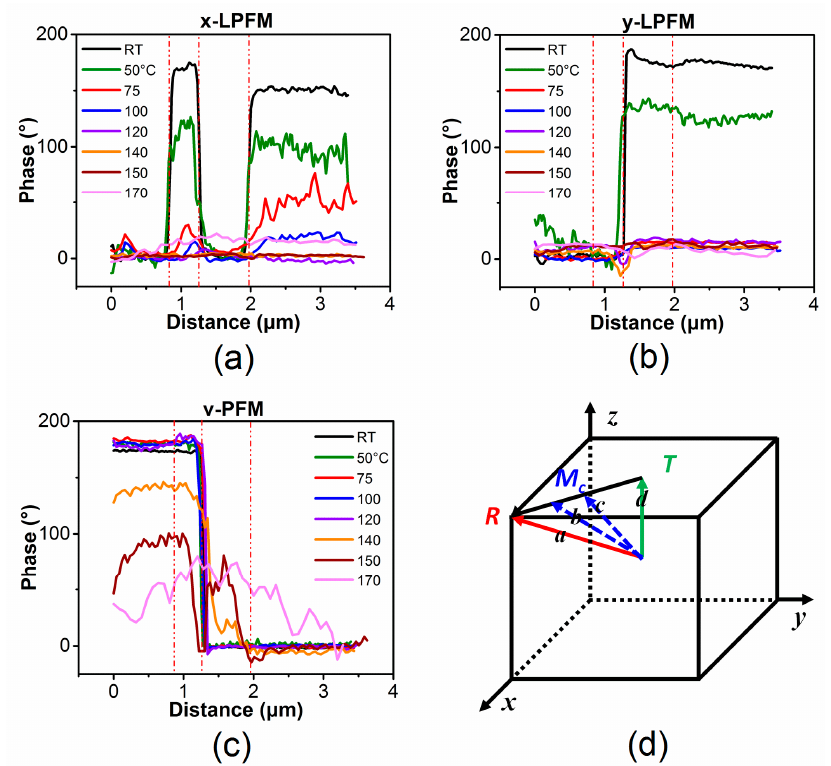
Figure 8. ( a – c ) Extracted profiles of the PFM phase in x-LPFM, y-LPFM, and VPFM along the line indicated in Figure 2a from room temperature to 170 °C; and ( d ) possible polarization rotation path (from R phase to T phase) of the (001)-cut PZN-7%PT single crystal. To summarize, PZN-7%PT undergoes an R → T phase transition at approximately 100 °C, and the T → C phase transition occurs between 140 °C and 170 °C. Based on the revised phase diagram of PZN-x%PT proposed by Chang et al., the de-poling temperature and the Curie temperature ( T C ) for PZN-7%PT are approximately 97 °C and 160 °C, re- spectively [18], which is in good agreement with our results. This indicates that investi- gating the phase transition process of PZN-x%PT single crystals by directly observing the domain structure evolution via the PFM technique is feasible and reliable. 4. Conclusions The domain structure and polarization rotation path of a [001]-oriented PZN-7%PT single crystal were studied by measuring the x-LPFM, y-LPFM, and VPFM images with a rotation stage at various temperatures. It was found that the local domain structure was a rhombohedral (R) phase with nanoscale twins at room temperature. Then, the domain structure changed to a tetragonal (T) phase at approximately 100 °C through an adaptive monoclinic (Mc) phase. The domain structure remained tetragonal (T) from 100 °C to 120 °C and transformed from the T phase to the C phase at temperatures between 140 °C and 170 °C. Therefore, the phase transition sequence of the (001)-cut PZN-7%PT single crystal with increasing temperature was R → Mc → T → C, which provides direct visualization of the local domain structure during the phase transition of PZN-7%PT single crystals. Supplementary Materials: The following are available online at www.mdpi.com/xxx/s1, Figure S1: PFM amplitude and phase of (001)-cut PZN-7%PT single crystal at 100°C: (a–c) amplitude images of x-LPFM, y-LPFM and VPFM, respectively; and (d–f) phase images of x-LPFM, y-LPFM and VPFM, respectively, Figure S2: PFM amplitude and phase of (001)-cut PZN-7%PT single crystal at